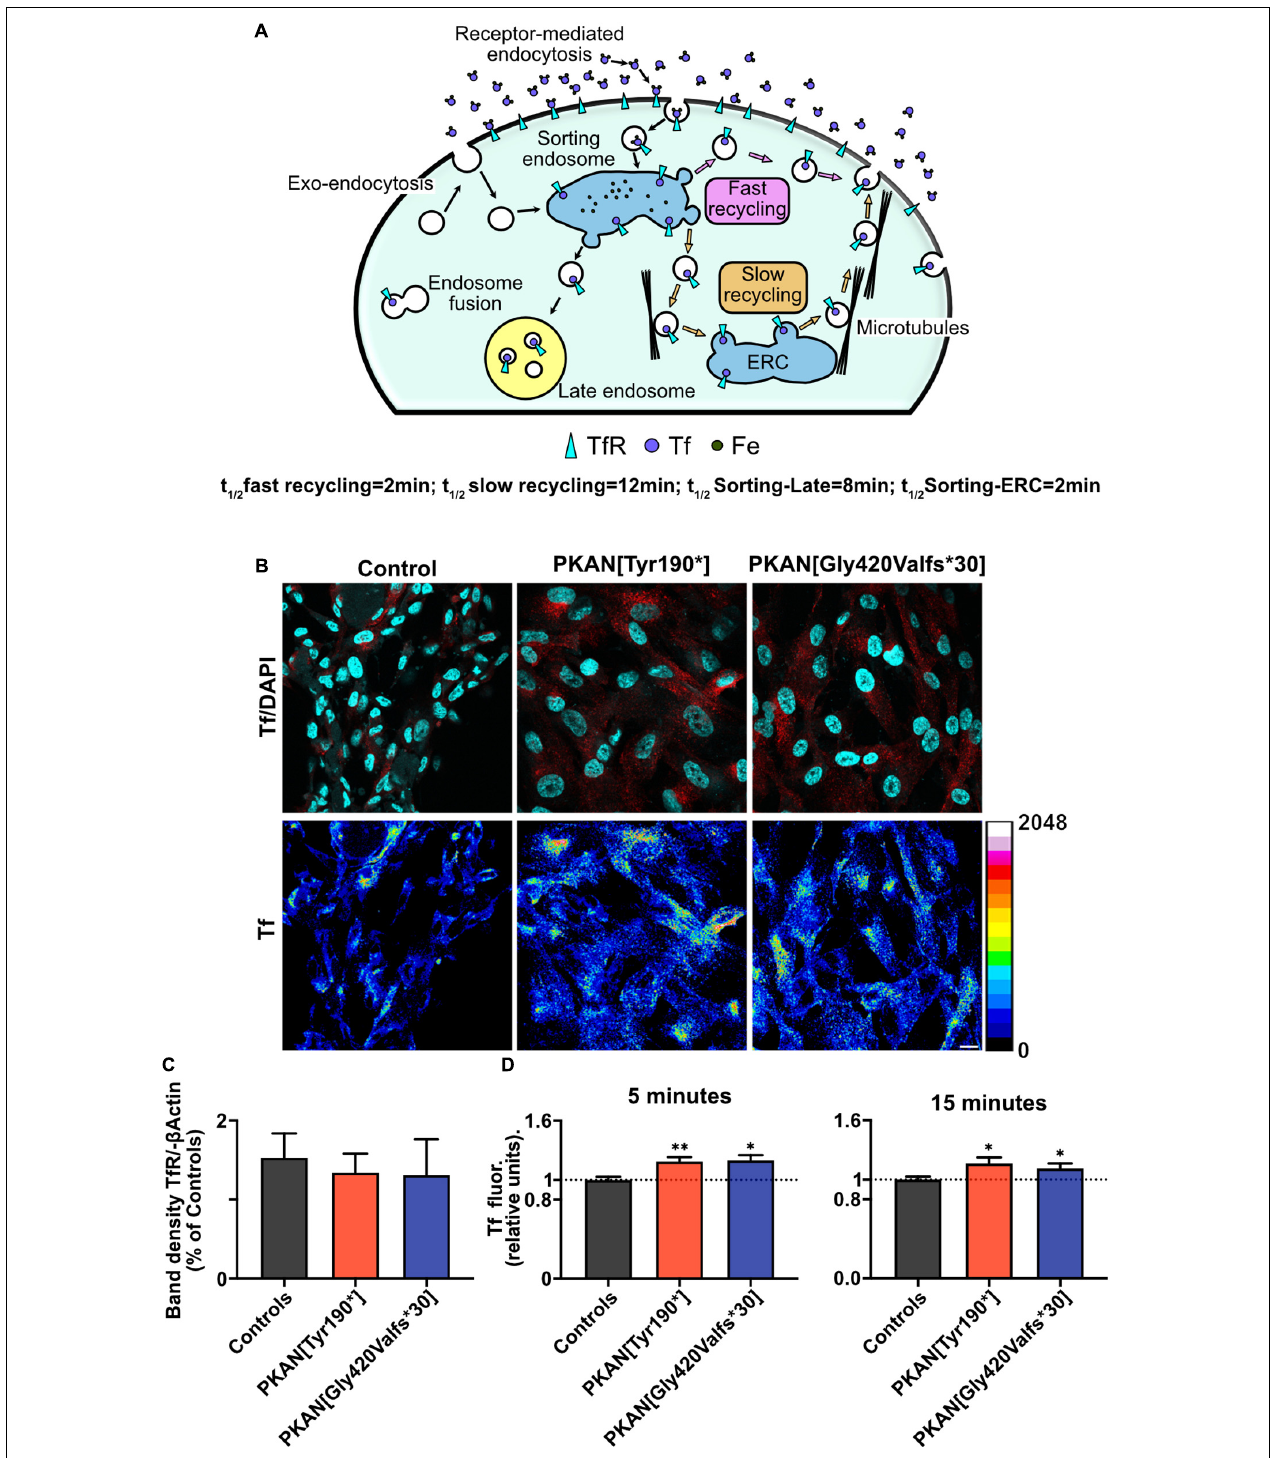
FIGURE 1 | PKAN astrocytes show an increased Tf uptake. (A) Schematic cartoon depicting the structure and functioning of the main endosomal compartments fate and vesicular tagging by Tf. (B) Confocal images of astrocytes, and their live uptake of fluorescent transferrin applied for 15 min (Tf red in upper panels, and 16 colors LUT, as indicated alongside, in lower panels), in controls and two different PKAN patients [PKAN(TYR190*); PKAN[Gly420Valfs*30)] (scale bar 20 µ m). (C) Quantification of Western blot analyses for TfR1 (ns, One-Way ANOVA, n = 3 independent replicates). (D) Histograms show the mean cellular Tf uptake in astrocytes from control and PKAN patients at different pulse and chase time (Mann–Whitney test, n ≥ 95 cells analyzed for each, from at least three independent replicates). Error bars are SEM for all. ∗ p < 0.05; ∗∗ p < 0.01; ∗∗∗ p < 0.001; ∗∗∗∗ p < 0.0001 for all.